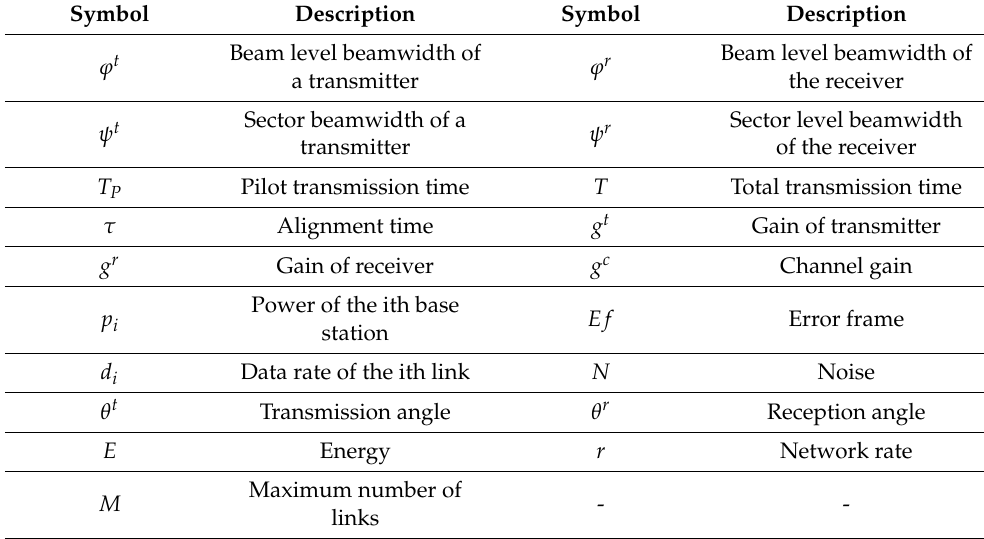
Table 3. Description of